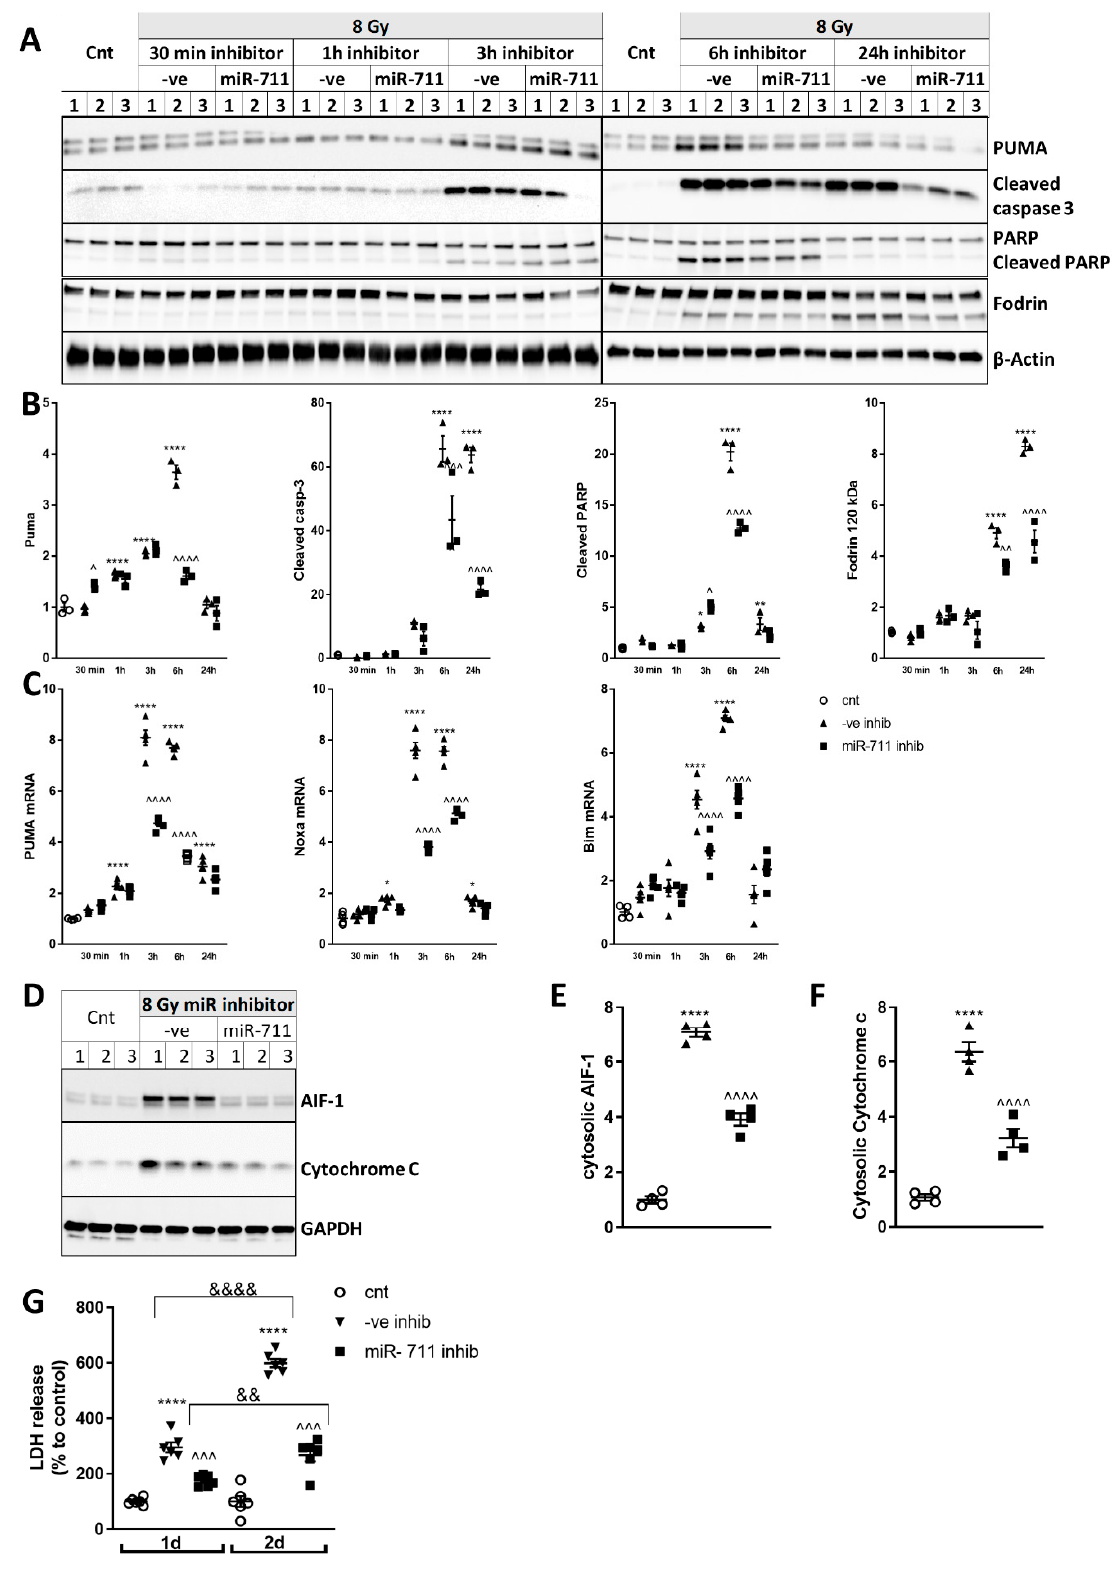
Figure 6. miR-711 inhibition attenuates IR-induced neuronal apoptosis. Western blot for Puma, cleaved caspase-3, PARP, α -fodrin and β -actin ( A ). ( B ) Quantification of levels of Puma (F(10,22) = 3.48, p = 0.0007 at 1 h, p < 0.0001 at 3 and 6 h after IR with miR-ve inhibitor, compared to control; for miR-711 inhibitor, compared to miR-ve inhibitor, p = 0.0312 at 30 min, p < 0.0001at 6 h), cleaved caspase-3 (F(10,22) =